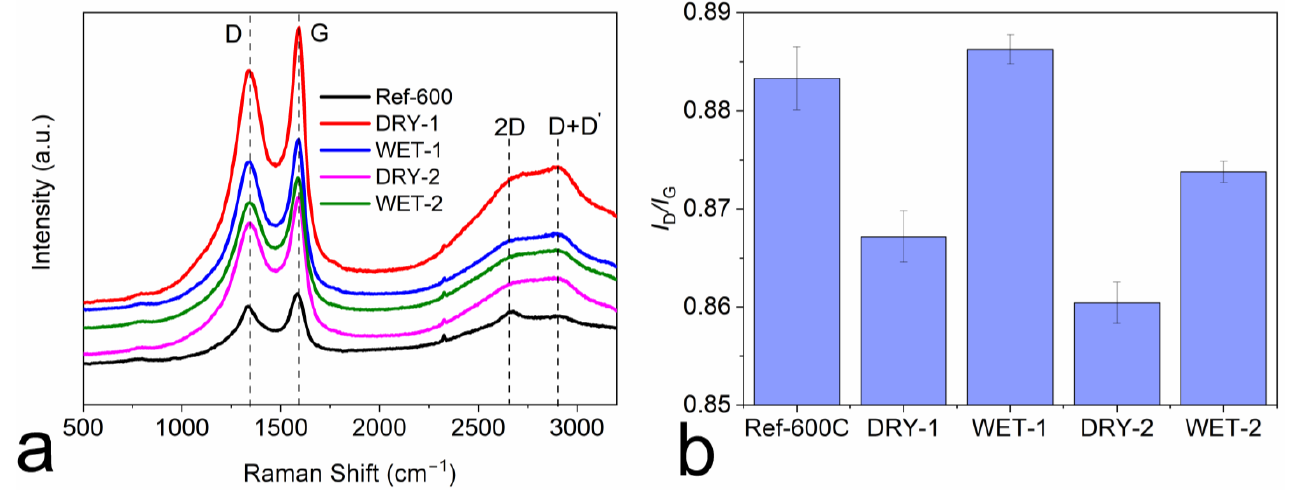
Figure 4. ( a ) Raman spectra of the wet and activated carbon samples and, ( b ) The intensity ratio of G band to D band ( I G / I D ).